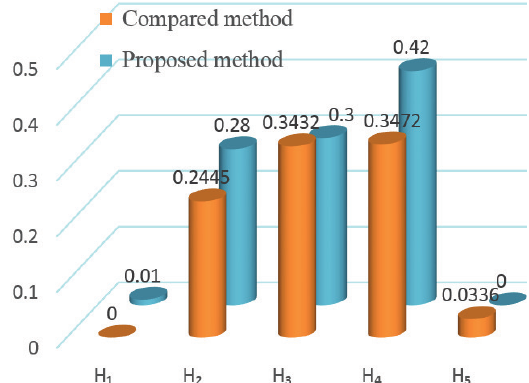
Figure 8. Comparison of the evaluation results of two